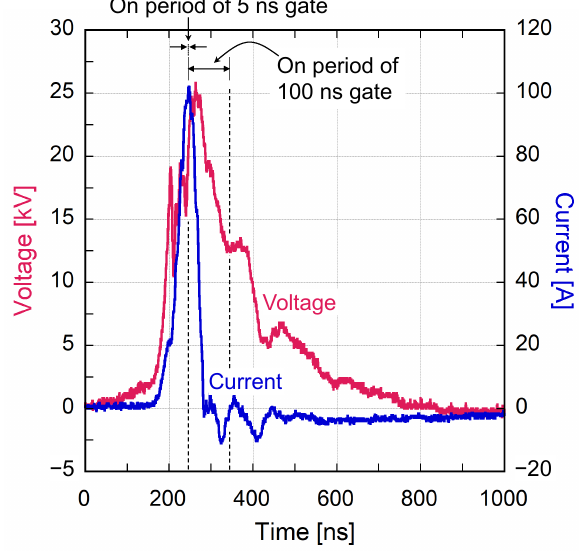
Figure 3. Typical voltage and current waveforms when pulsed streamer discharges were generated in the overflow-type reactor. These discharges were driven by nanosecond-pulsed voltages whose peak value and repetition frequency were 24 kV and 100 pps, respectively. Time relationship between the gate of an intensified charge-coupled device (ICCD) camera and voltage and current waveforms is also shown to indicate when the streamer discharges were captured by the ICCD camera in Figure